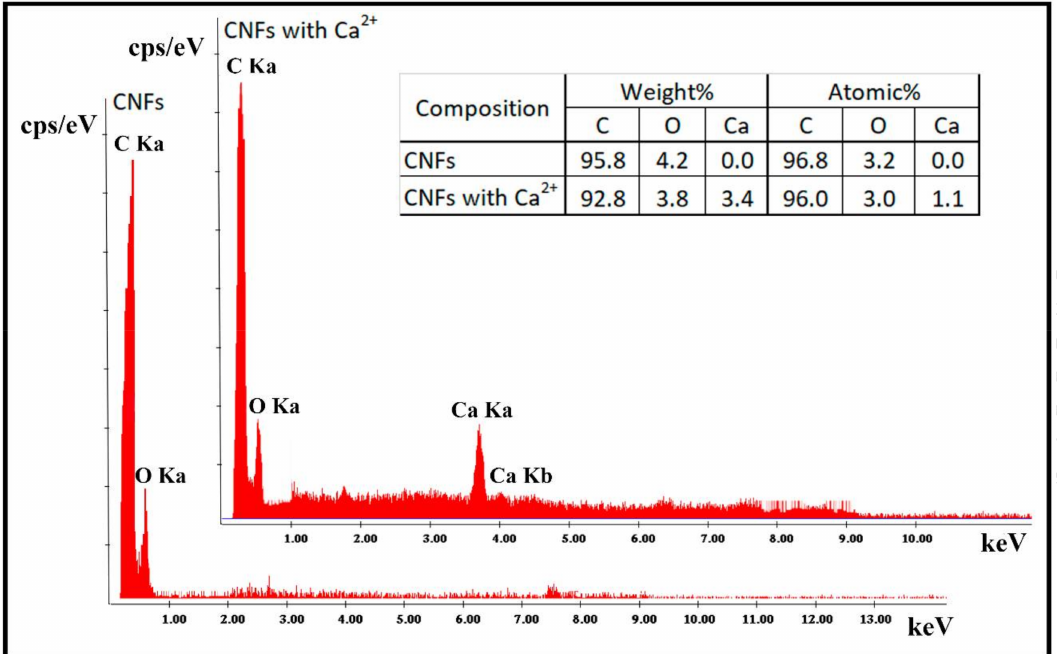
Figure 4. Elementary composition of the carbon nanofibers with and without cross-linking with Ca 2+ measured by EDS at 20